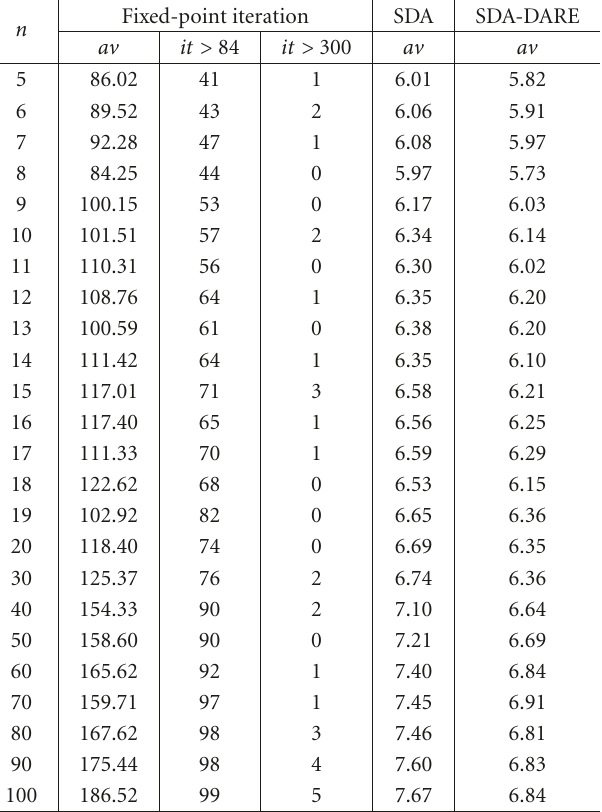
Table 1: First set of test